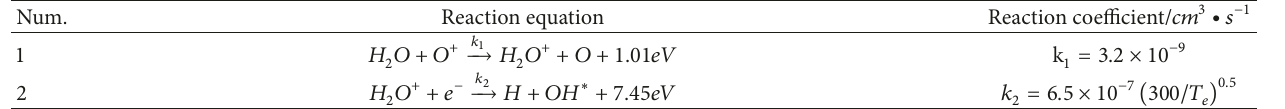
Table 2: Reactions stimulated by H 2 O release in the ionosphere [13].